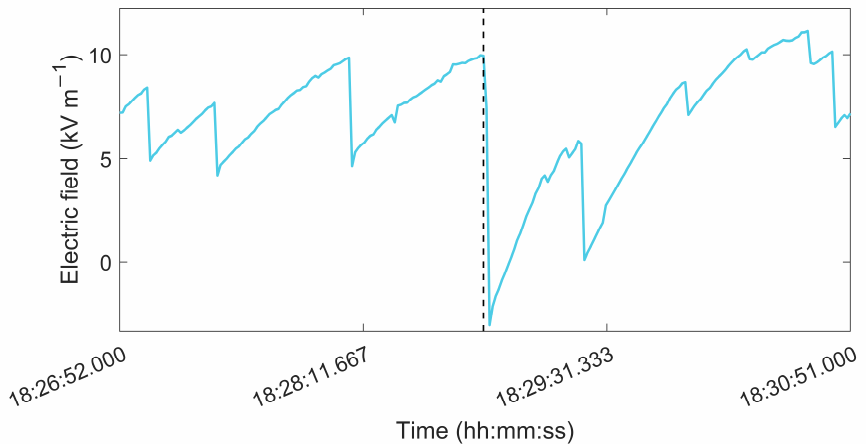
Figure 1. Atmospheric average electric field (AAEF) waveform associated with a triggered lightning flash (TLF) in Guangdong on 9 June 2016. The black dashed line represents the moment of triggering operation onset. Each abrupt AAEF change corresponds to a lightning event. The sign of AAEF follows the physics definition, that is, the positive (negative) value is linked with upward (downward) line of